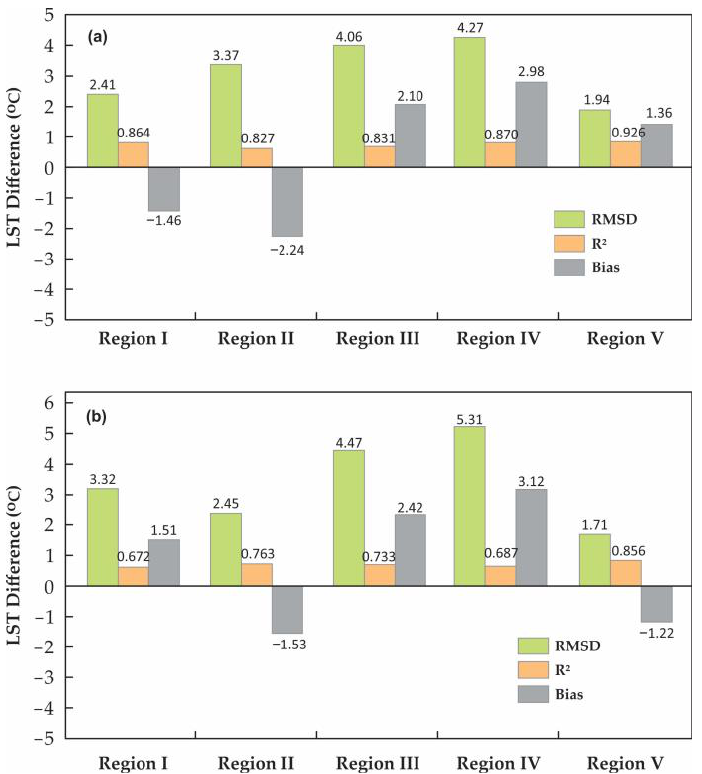
Figure 4. Cross-validation errors between LSTs of MERSI-II, and MODIS ( a ) MYD11A1 and ( b ) MYD21A1 LST products over five sub-regions of Pakistan.